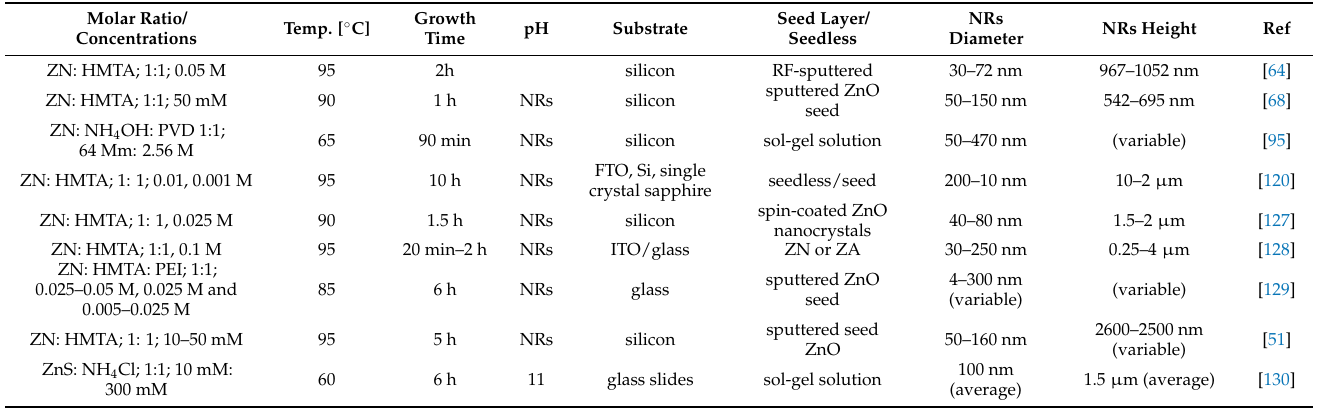
Table 2. Illustration of selected experimental data and deposition-growth parameters for ZnO seed layer and ZnO nanorod arrays synthesized by chemical bath deposition and hydrothermal methods. Molar Ratio/